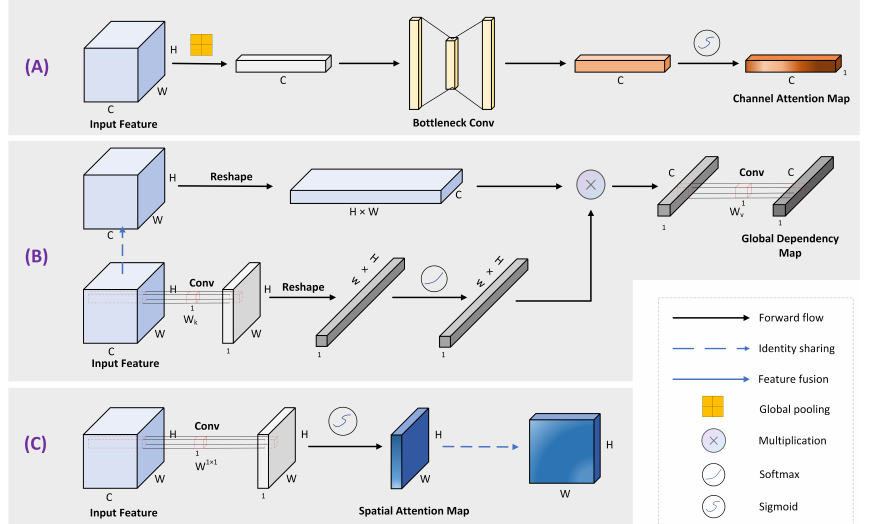
Figure 3. Diagram of each attention sub-module, where ( A – C ) denote CA Model, GD Model, and SA Model,